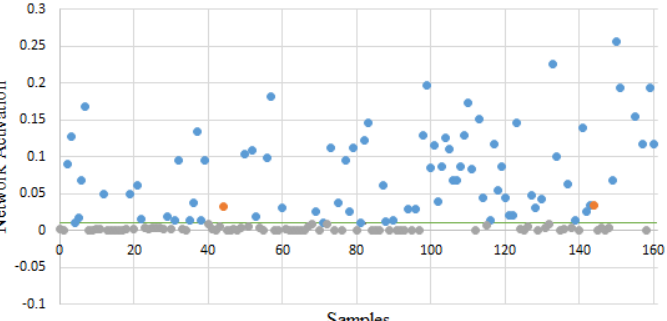
Figure 24. Activation values on network trained with UECFOOD256 dataset with a test network of 200 food samples. Blue dots represent correctly labeled food images. Orange dots show mislabeled food images. Grey dots represent food images that are determined as noisy